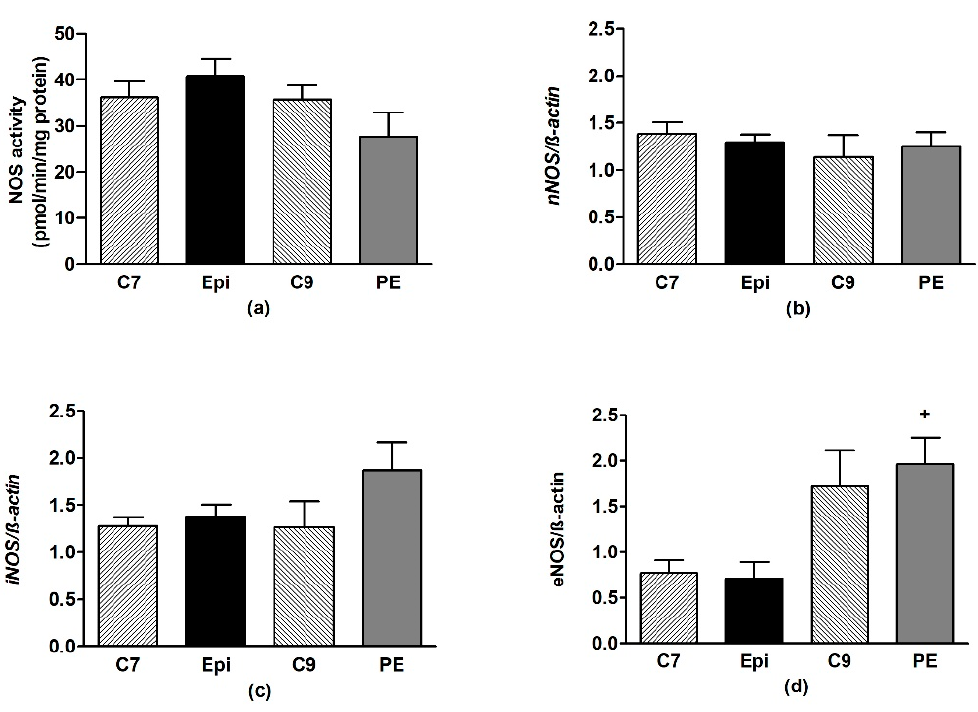
Figure 6. The effect of (–)-epicatechin on the nitric oxide synthase (NOS) activity ( a ) and gene expression of neuronal nNOS ( b ), inducible iNOS ( c ) and endothelial eNOS ( d ) in the frontal neocortex of borderline hypertensive rats. The values represent the mean ± SEM. + p < 0.05 vs. Epi group. Abbreviations. C7: seven-week-old control group, C9: nine-week-old control group, Epi: (–)-epicatechin treatment group, PE: (–)-epicatechin post-treatment group.